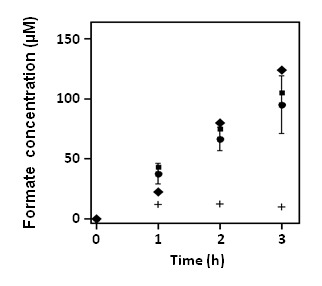
Substrate dependence and light sensitivity of PsFDH(QN).The formate production in the presence of 1 mM NADPH (circles) were compared with that in the presence of 10 mM NADPH (diamonds), that under visible light at an intensity of 1000 µmol photon m-2 s-1 (squares), and that in which NaHCO3 was used instead of CO2 (crosses). These experiments were performed as mentioned in Figure 2, except as described above.